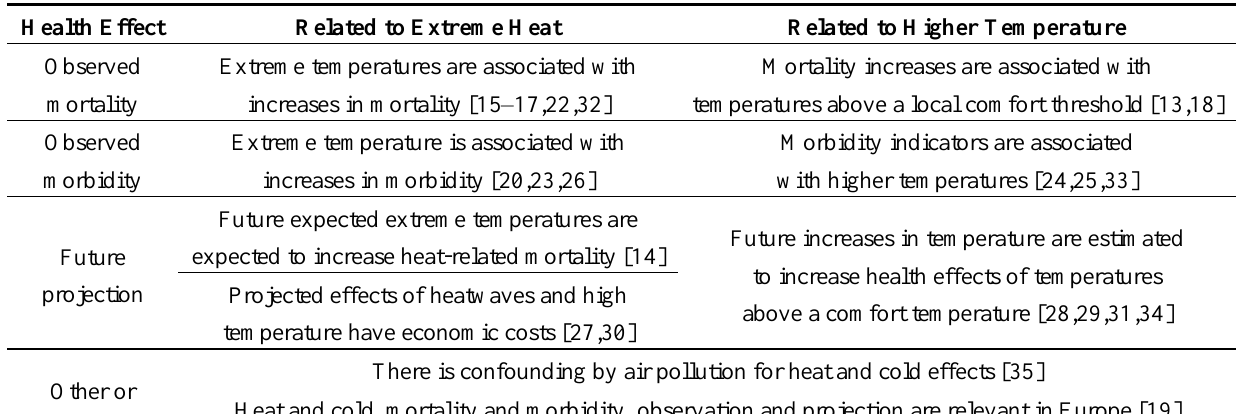
Table 2. Search results about health effects of extreme heatwaves and high temperature